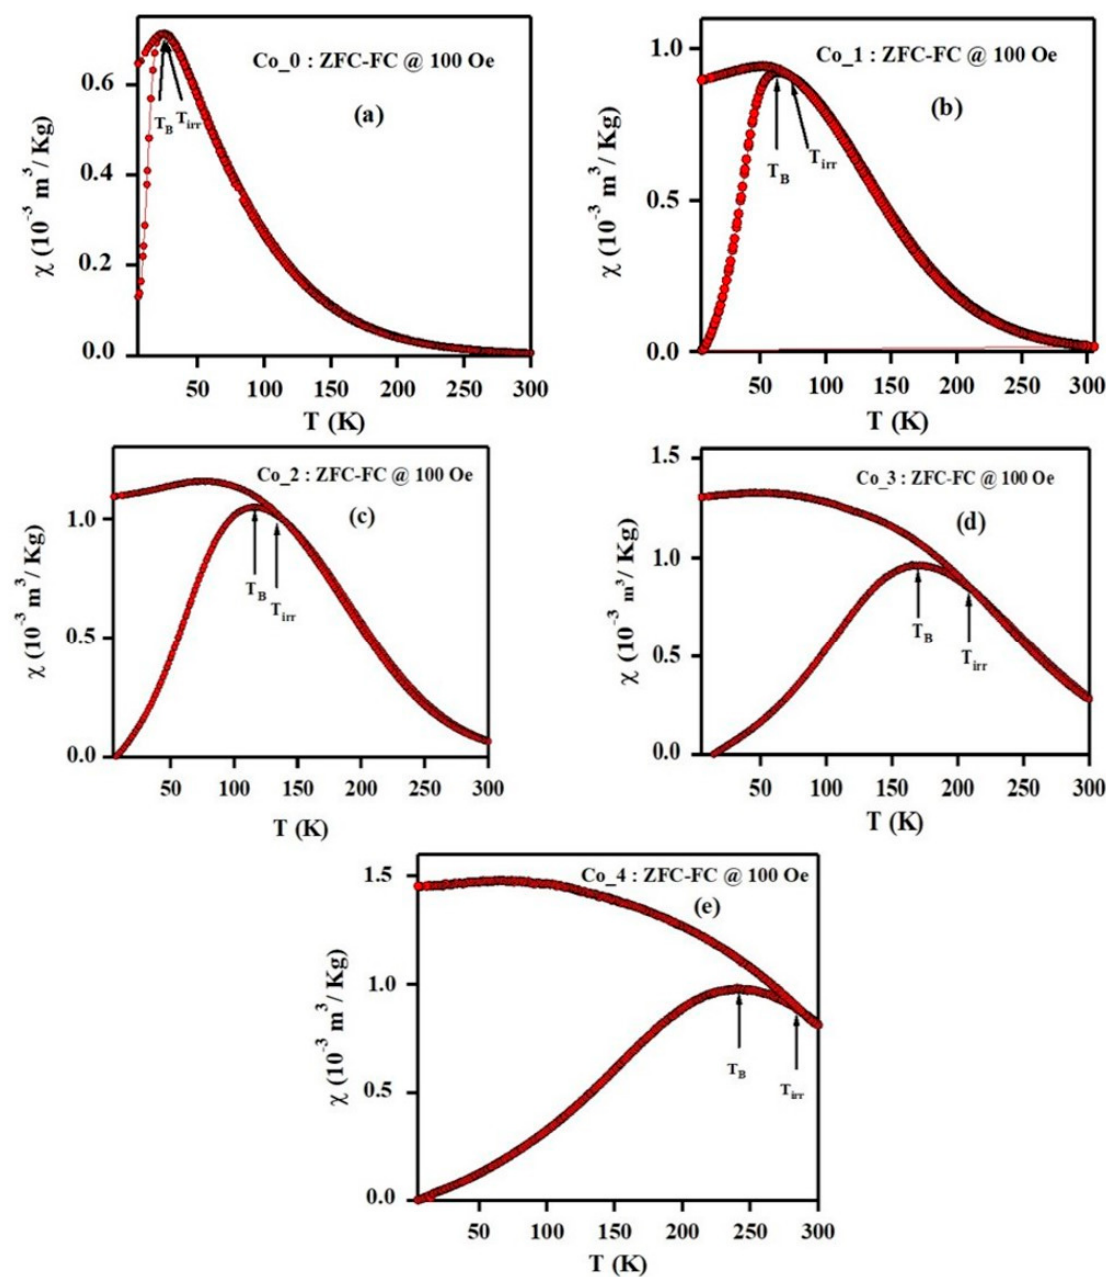
Figure 8. ZFC-FC magnetization curves measured with H = 100 Oe for Co x Zn 1-x Fe 2 O 4 ferrite systems ( a ) x = 0.00, ( b ) x = 0.10, ( c ) x = 0.20 and ( d ) x = 0.30, ( e ) x = 0.40.